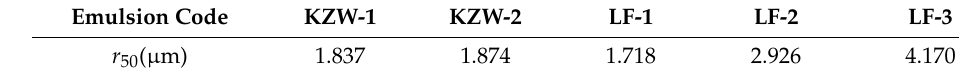
Figure 1. The particle size distribution of bitumen emulsions, ( a ) Differ ential distribution, ( b ) Cumulative percentile. Table 2. Bitumen droplet size at the 50th cumulative volume percentile.